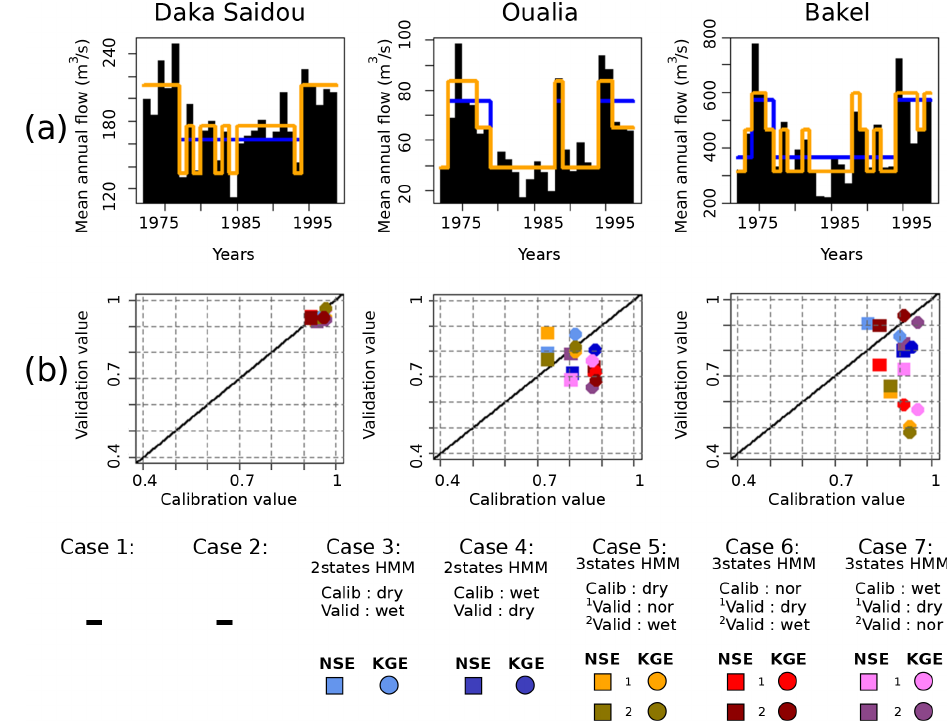
Figure 8. The dry subsequence T 1972–1998 . The caption is identical to the caption of Fig. 6 but for the T 1972–1998